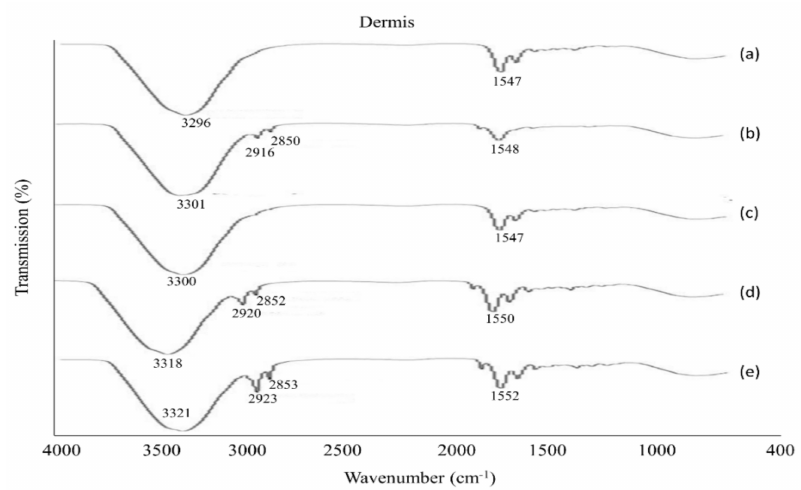
Figure 7. ATR-FTIR spectra of the dermis ( a ) untreated skin, and skin treated with ( b ) F1, ( c ) F2, ( d ) F3 and ( e ) F4, data are expressed as mean ± S.D., n =